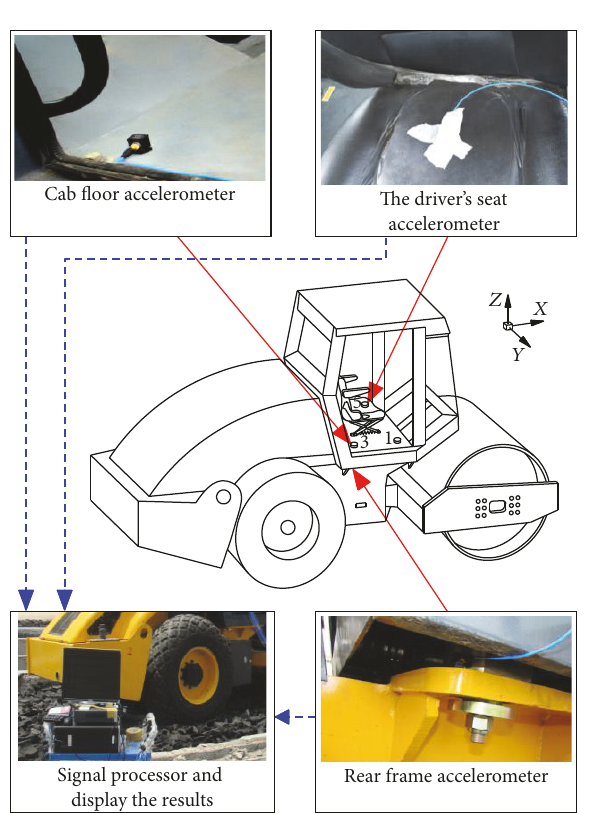
Figure 7: Diagrammatic sketch of the experimental